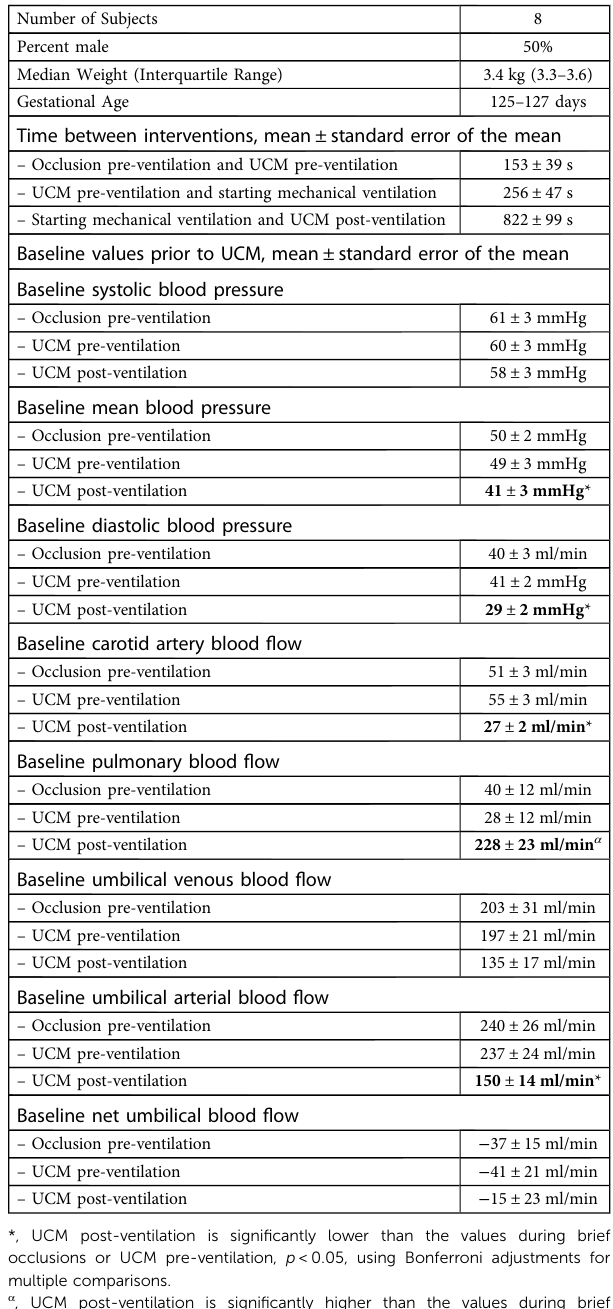
TABLE 1 Baseline characteristics and baseline measurements prior to umbilical cord intervention. UCM=umbilical cord